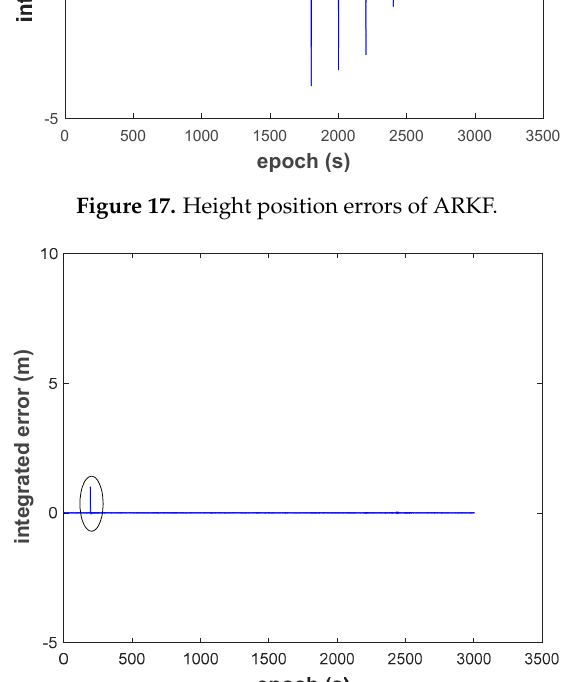
Figure 18. Height position errors of RRKF.